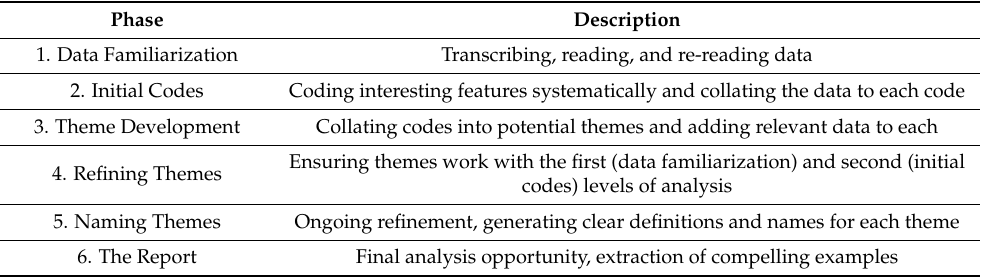
Table 2. Six phases of thematic analysis adapted from Braun and Clarke